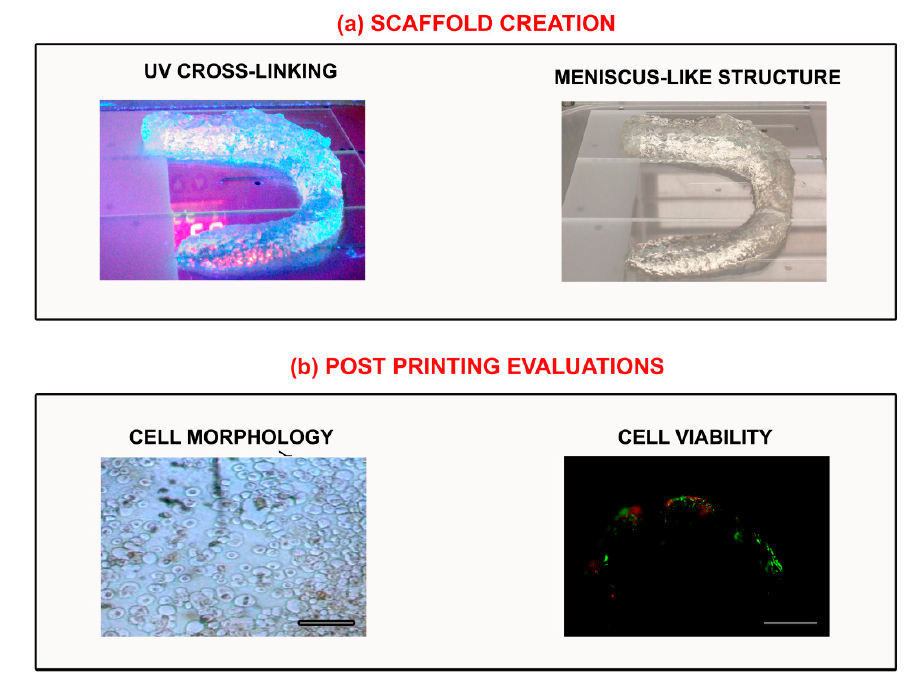
Figure 2. ( a ) Custom-made printed meniscal model. The construct is realized in a poly(ethylene glycol) methacrylate (PEGMA)-based hydrogel (Bioink, RegenHU, CH) that requires UV light cross-linking (365 nm wavelength) to improve structural and mechanical properties; ( b ) Post-printing evaluations: mesenchymal stem cell (MSC) distribution by microscopy and cell viability by the Live and Dead test (green: live cells (FITC channel); red: dead cells (TRITC channel); scale bar: 100 µm).